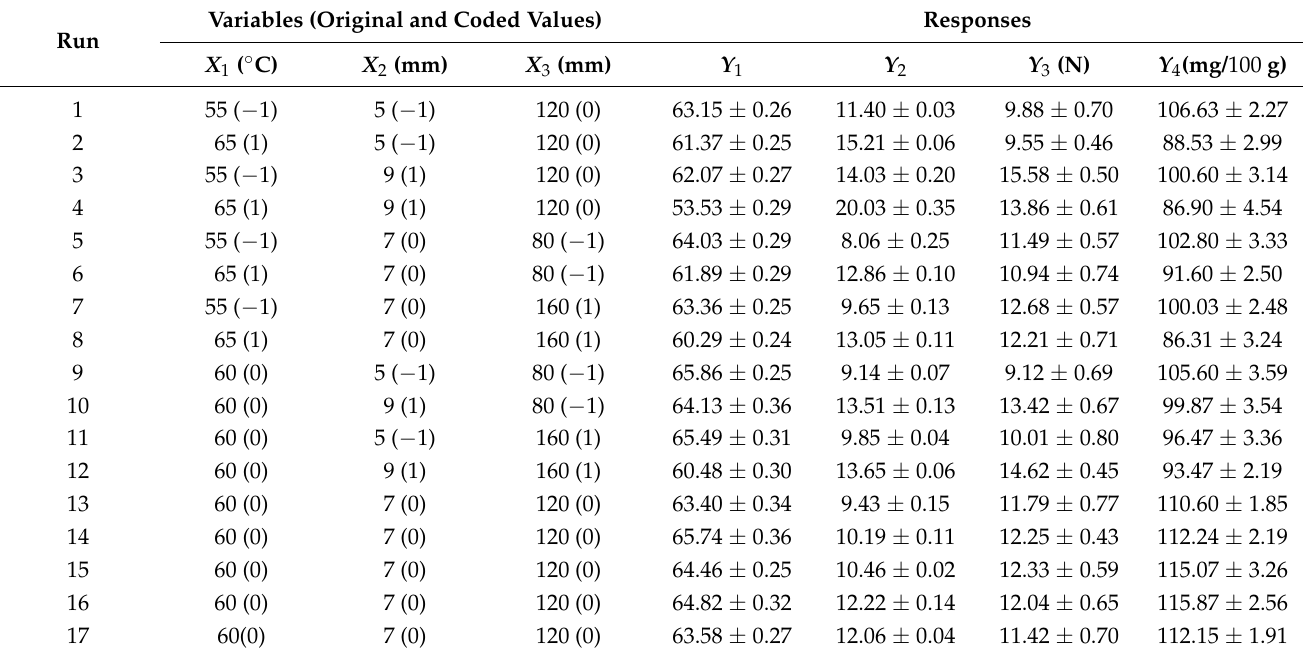
Table 4. Box–Behnken center design and